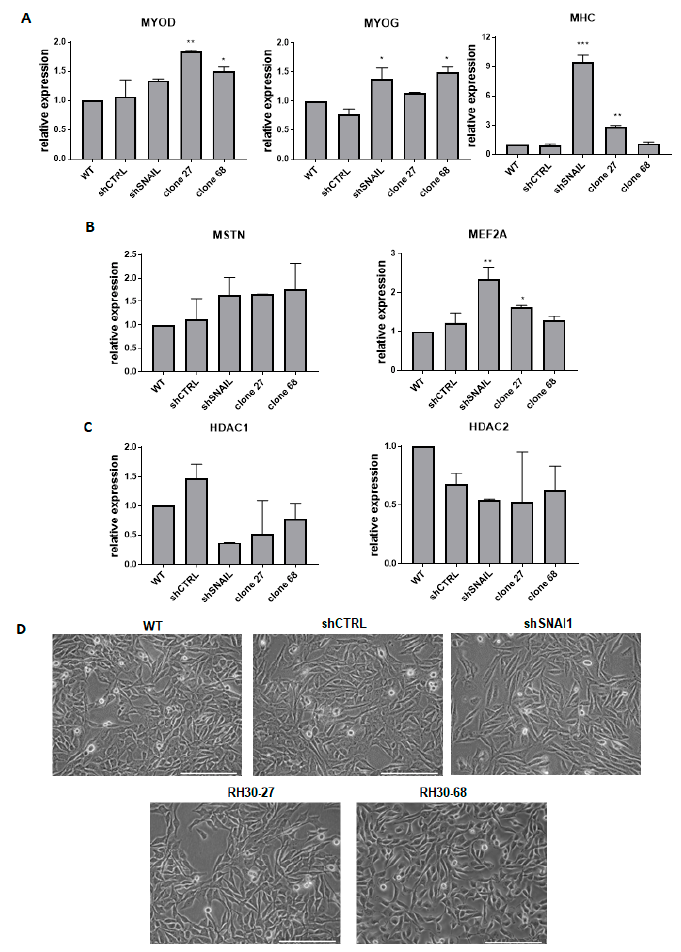
Figure 4. The effect of SNAI1 on rhabdomyosarcoma development. ( A ) qPCR analysis of myogenic regulatory factors: MYOD, MYOG, and MHC in the SNAI1 KOs and KDs (n = 2). ( B ) mRNA levels of